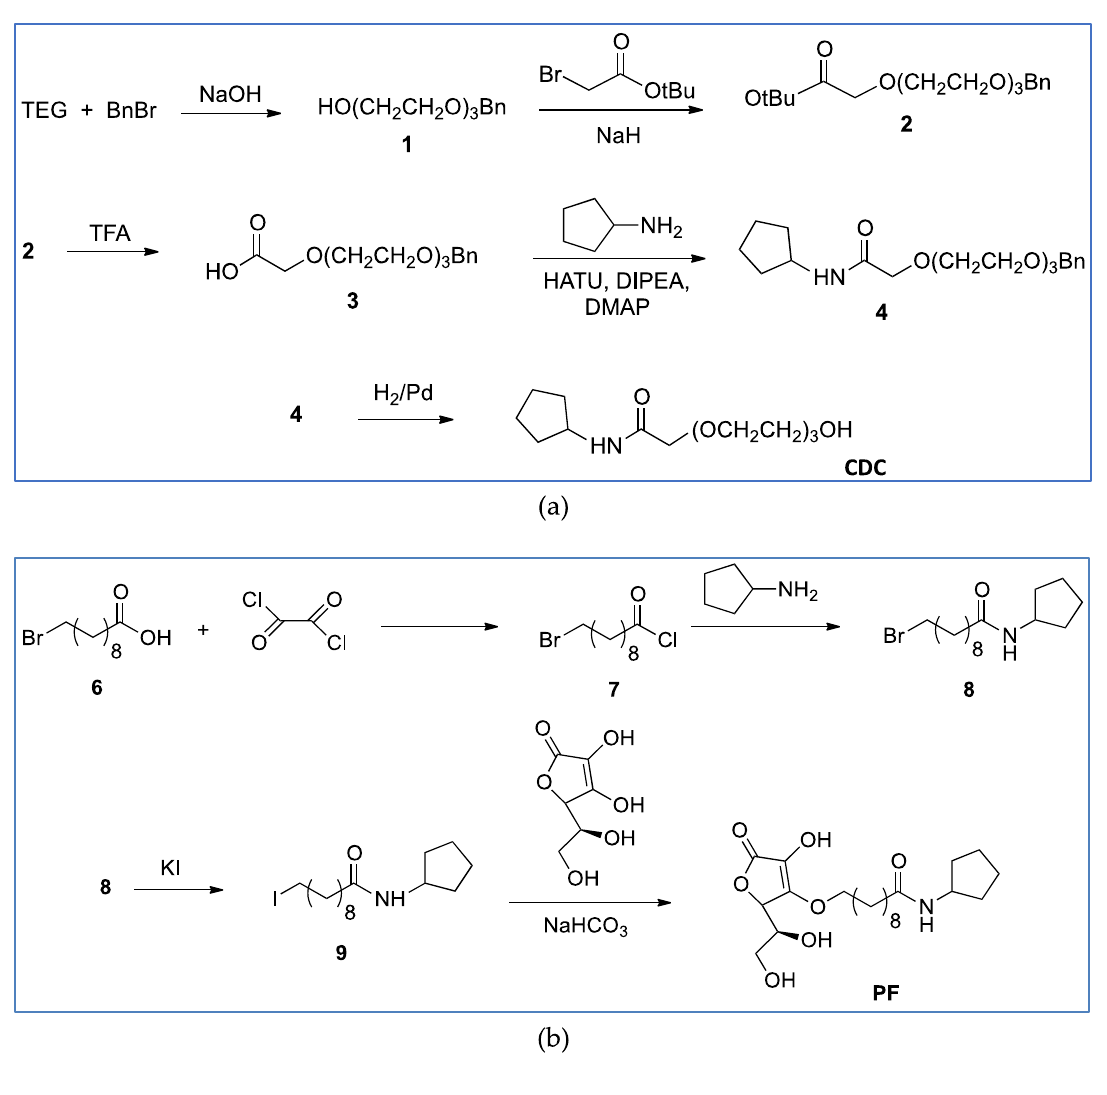
Figure 1. Synthetic flow charts for CDC ( a ) and PF ( b ). 1 H and 13 C NMR spectra values of final products ( c ).